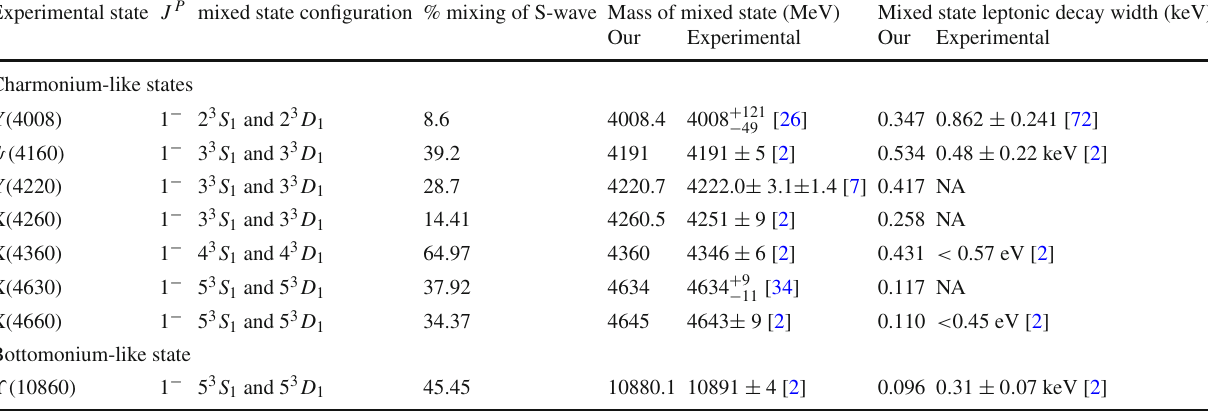
Table 11 Mixing angle and the leptonic decay widths of S–D-wave admixture states Experimental state J P mixed state configuration % mixing of S-wave Mass of mixed state (MeV) Mixed state leptonic decay width (keV) Our Experimental Our